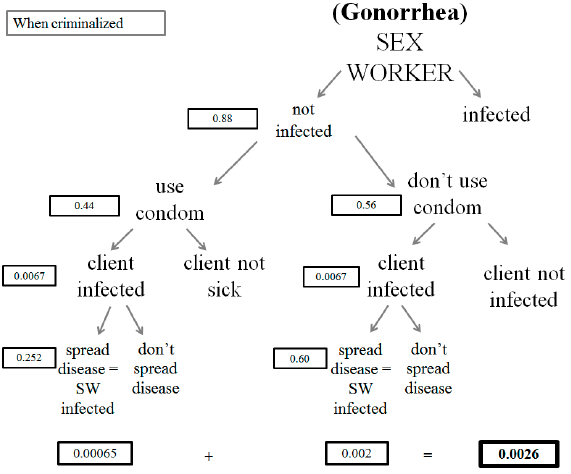
Figure A7. Risk of HIV transmission to a sex worker under decriminalization.